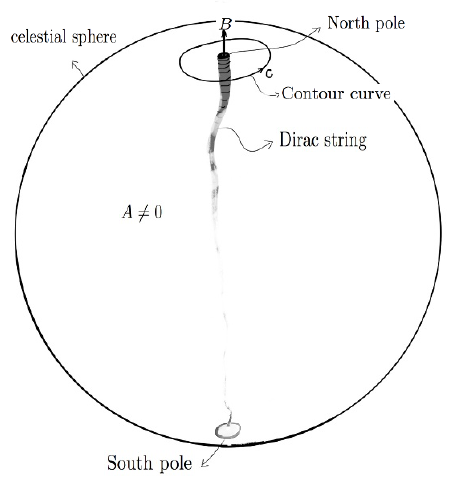
Figure 4 . A depiction of the pure gauge transformation which at the celestial sphere becomes ln z . This gauge transformation may be viewed as a Dirac string connecting the south and north poles of the celestial sphere with some bulk extension. It produces a \magnetic charge" at the north pole and an \anti-magnetic charge" at the south pole. The observer at the north pole who uses complex coordinates z; (cid:22) z however, does not have access to the charge in the south pole and hence only sees a net magnetic charge. Similar picture may also be drawn for other higher pole charges. Note that in 2+1 spacetime (boundary observers), there are three residual gauge symmetry components, two for the electric one-form (or vector) and one for the magnetic two-form (or scalar). Therefore, for the boundary observer the net magnetic monopole is computed as the integral of two-form B on the region con(cid:12)ned by the contour c , or equivalently, H A c